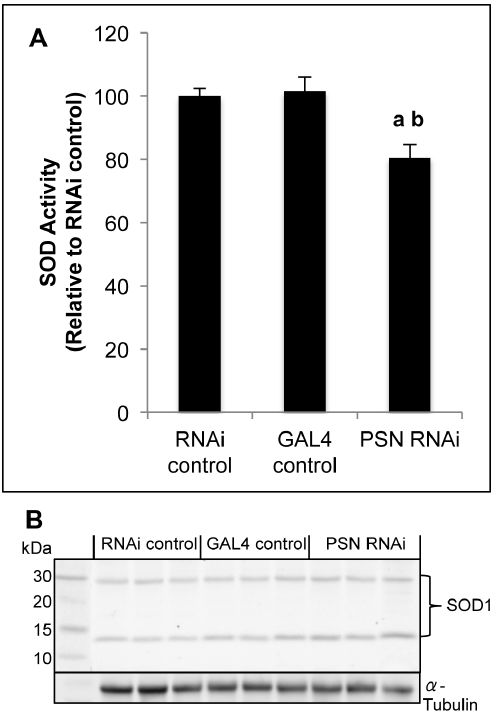
Figure 5. SOD activity in Drosophila . SOD activity (A) and SOD1 protein levels (B) were assessed for control (RNAi control, GAL4 control) and midgut PSN knockdown (PSN RNAi) third instar larvae. (A) SOD activity was measured colorimetrically and expressed relative to activity in RNAi control larvae. Values are mean activity with S.E.M. from twenty replicates of 10 larvae. PSN knockdown Drosophila had reduced SOD activity. a Significant difference from RNAi control, b significant difference from GAL4 control, as determined by one-way ANOVA with Tukey’s post-hoc test (P , 0.05). (B) SOD1 monomer and dimer were identified by western immunoblotting with a SOD1 antibody. a -Tubulin used as a loading control. SOD1 protein levels were not reduced by PSN knockdown.